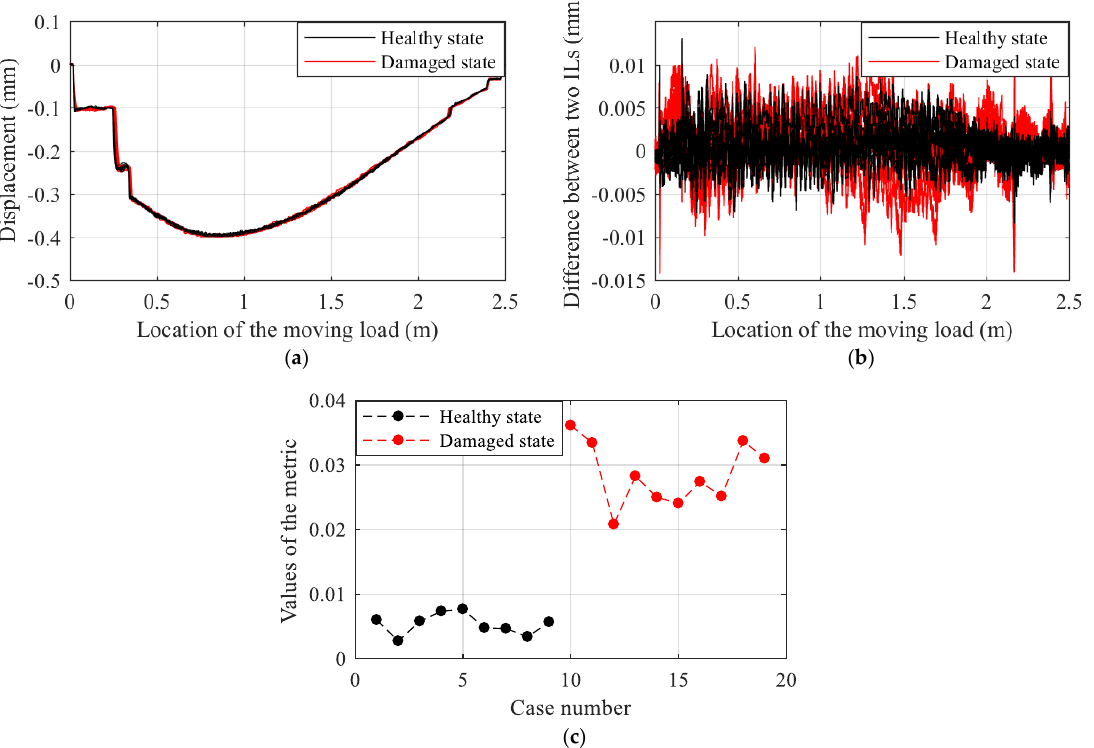
Figure 14. Comparison of the damage detection performance between the traditional method and the proposed method under the same loading conditions before and after damage: ( a ) measured displacement ILs; ( b ) difference between the measured displacement ILs by the traditional method; ( c ) metric of the damage feature by the proposed method.